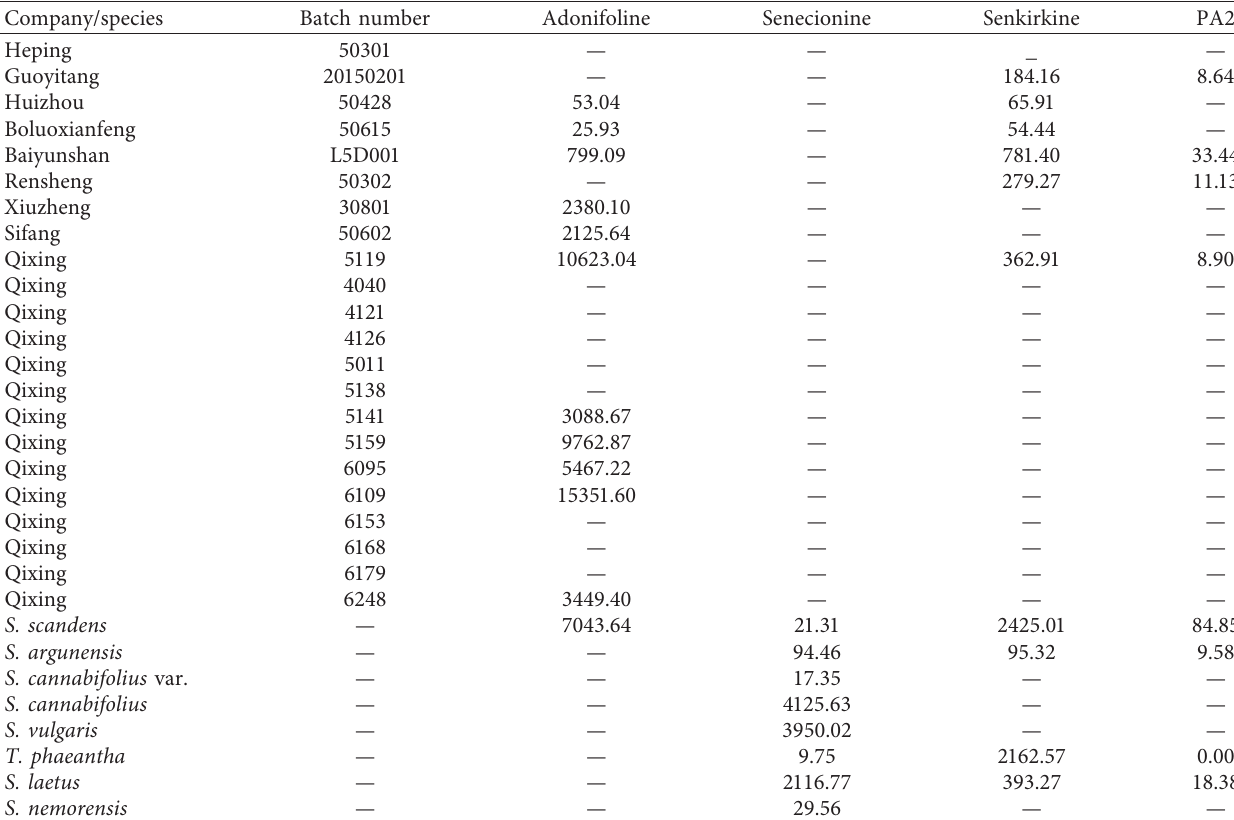
Table 2: PAs content in tablets of different companies, batches, and Senecio plants.